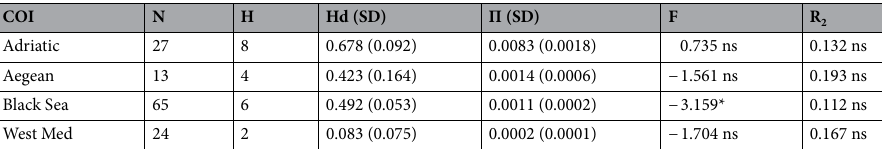
Table 2. Summary statistics of the Cytochrome oxidase I (COI) sequences of Tritia neritea analyzed in this study. N = number of sequences; H = number of haplotypes; Hd (SD) = Haplotype diversity with standard deviation; Π (SD) = Nucleotide diversity with standard deviation; F = Fu & Li 115 neutrality index; R 2 = Ramos- Onsins & Rozas 116 neutrality index.